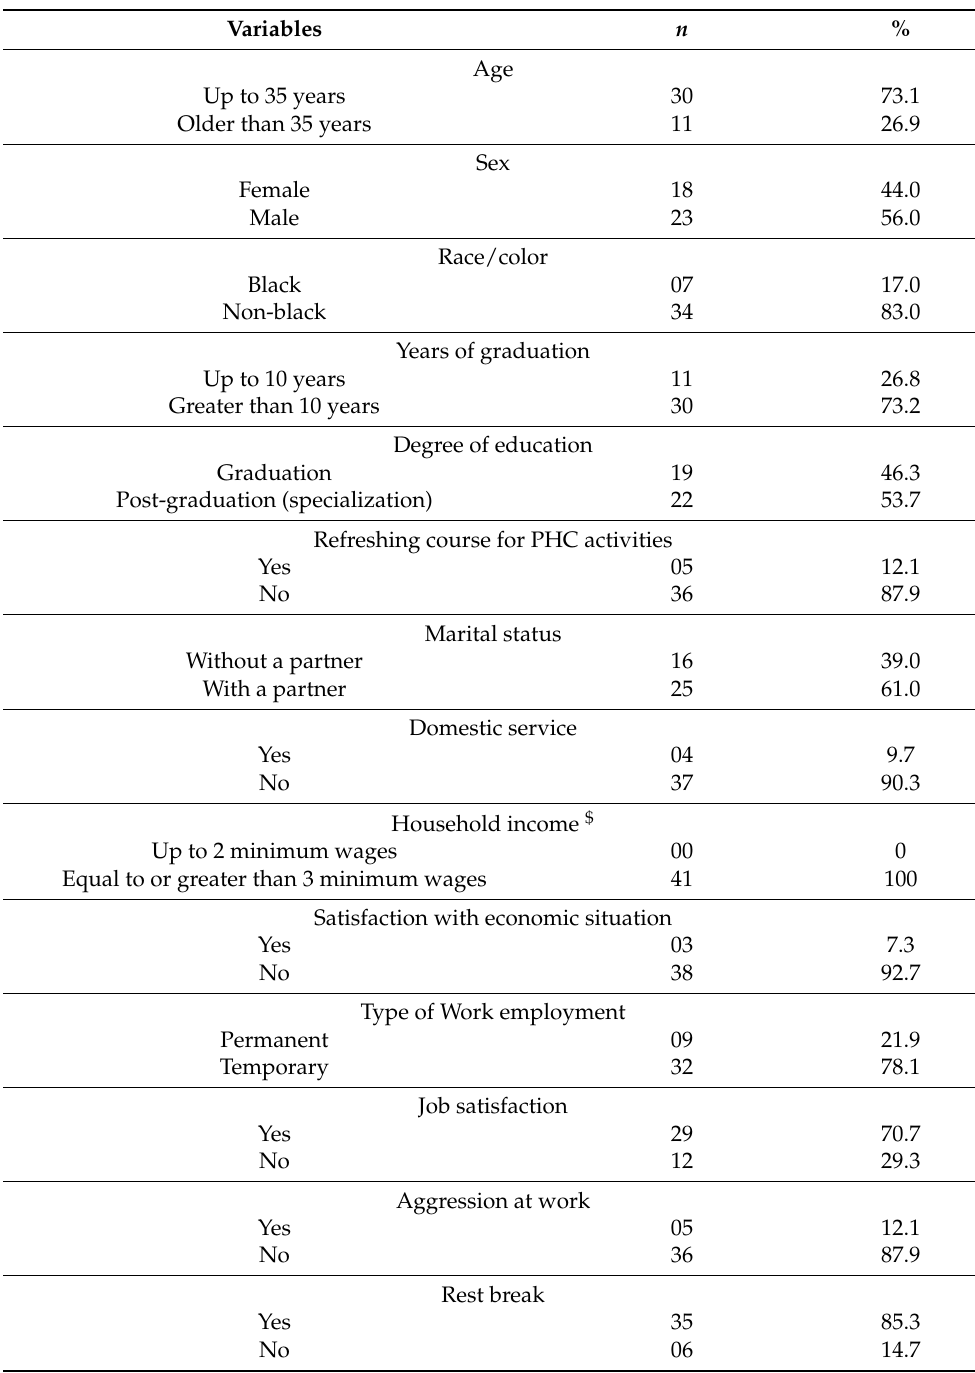
Table 1. Sociodemographic, economic, and labor characteristics of primary health care physicians. Mesoregion of Salvador, Bahia, Brazil, 2017 ( n =